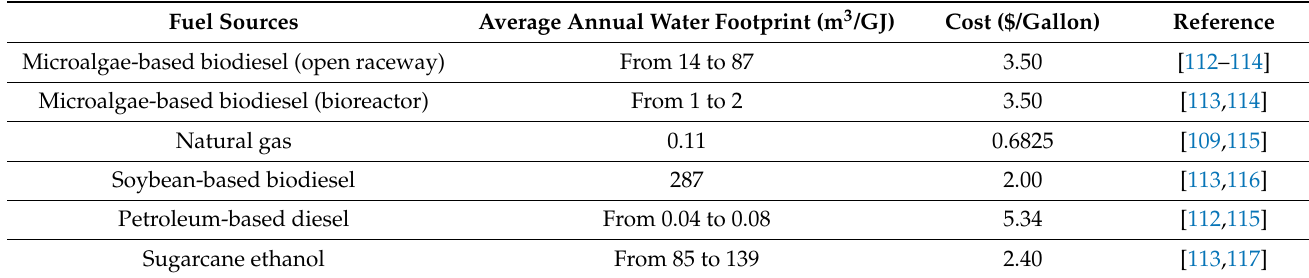
Table 4. Average annual water footprint and costs of several fuel